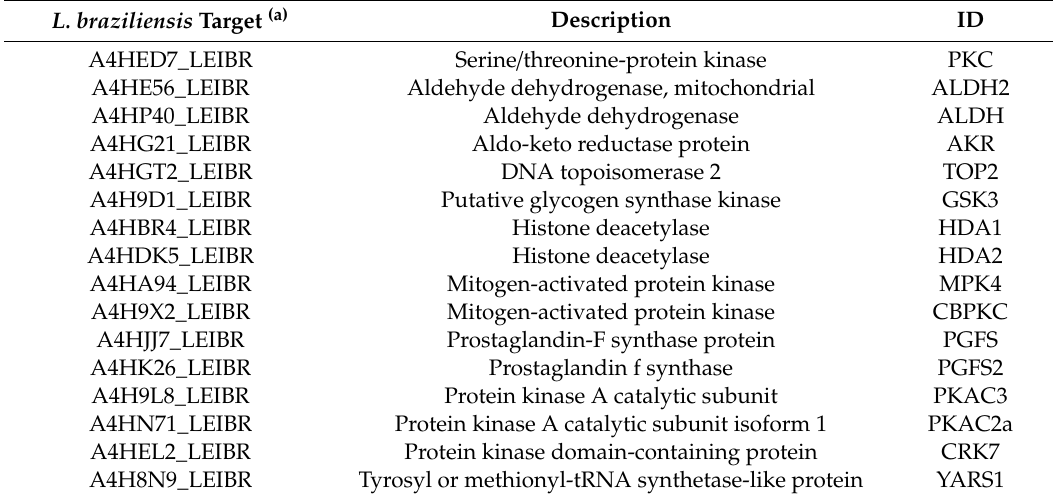
Table 2. Potential targets of compound 9 in Leishmania braziliensis identified by the homology-based target fishing